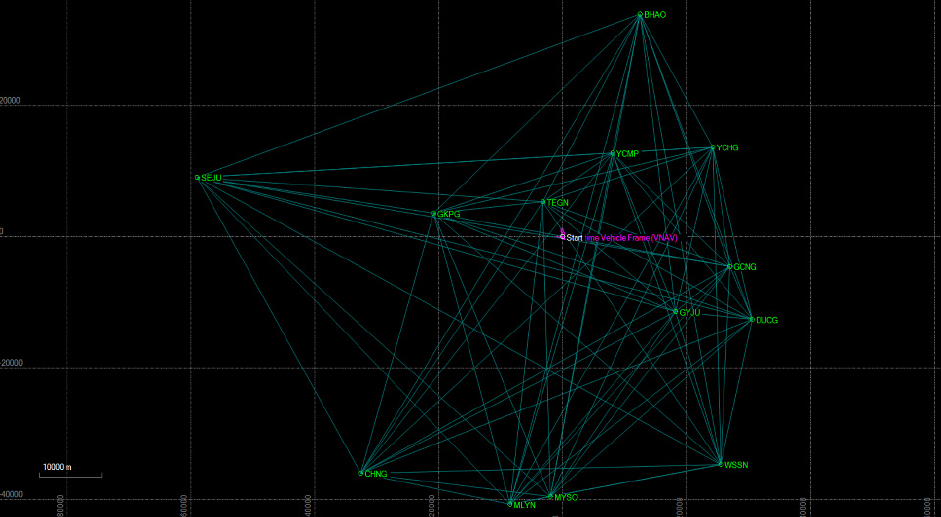
Figure 7. Example of synchronizing the GNSS movement path raw data with standard GNSS observations.